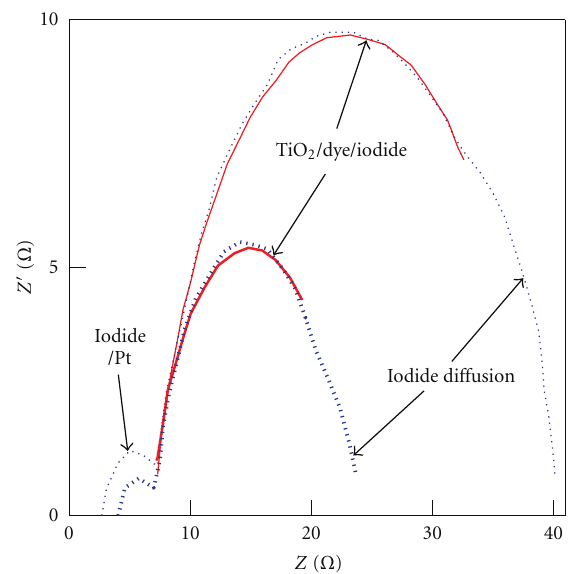
Figure 8: Electrical impedance spectra of DSCs under irradiation (100mW cm − 2 , AM 1.5): TiO 2 -BM paste (thick-dotted line), TiO 2 - MG paste (thin-dotted line). Each solid curve shows the fitting results.